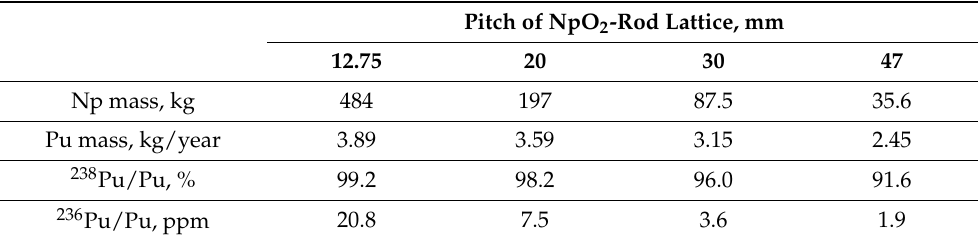
Table 4. Plutonium production rate and plutonium isotope composition caused by elongated pitch sof NpO 2 -rod lattice (the encirclement by Pb-FAs).